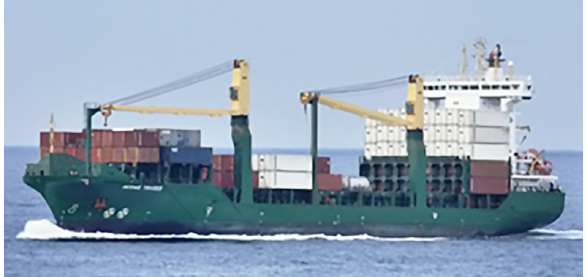
Figure 11. Seat of the flange of the freshwater cooler of the LT contour for cooling auxiliary mechanisms on a container ship MERWE TRADER (position 1 – side wall)